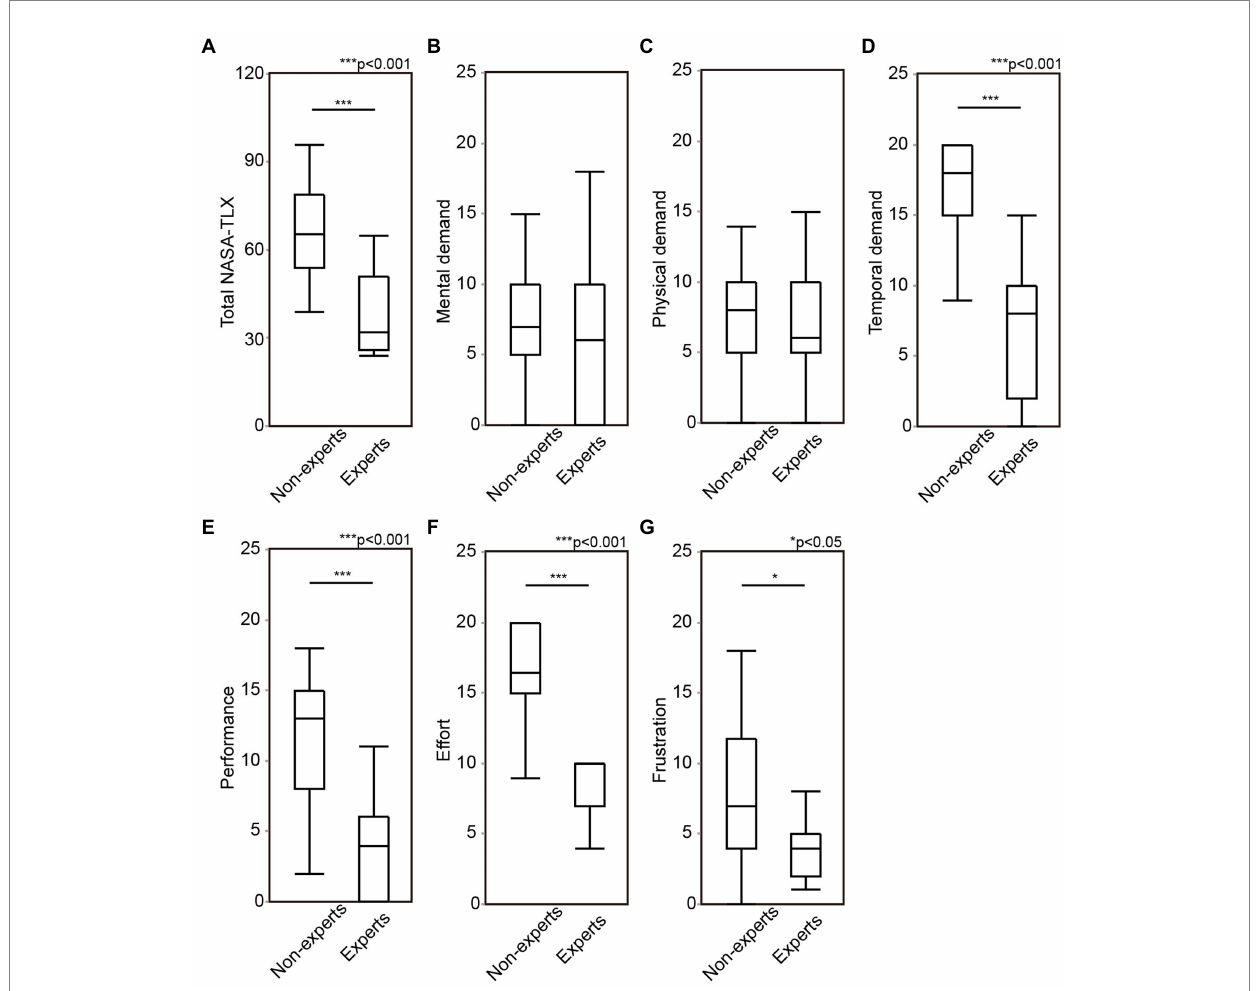
FIGURE 3 The comparison of mental workload during ESS between experts and non-experts. Total score of NASA-TLX (A) , mental demand (B) , physical demand (C) , temporal demand (D) , performance (E) , effort (F) , and frustration (G) were compared between experts and non-experts. ESS, endoscopic sinus surgeries; OSATS, objective structured assessment of technical skills; NASA-TLX, national aeronautics and space administration-task load index. * p < 0.05, ** p < 0.01, *** p <